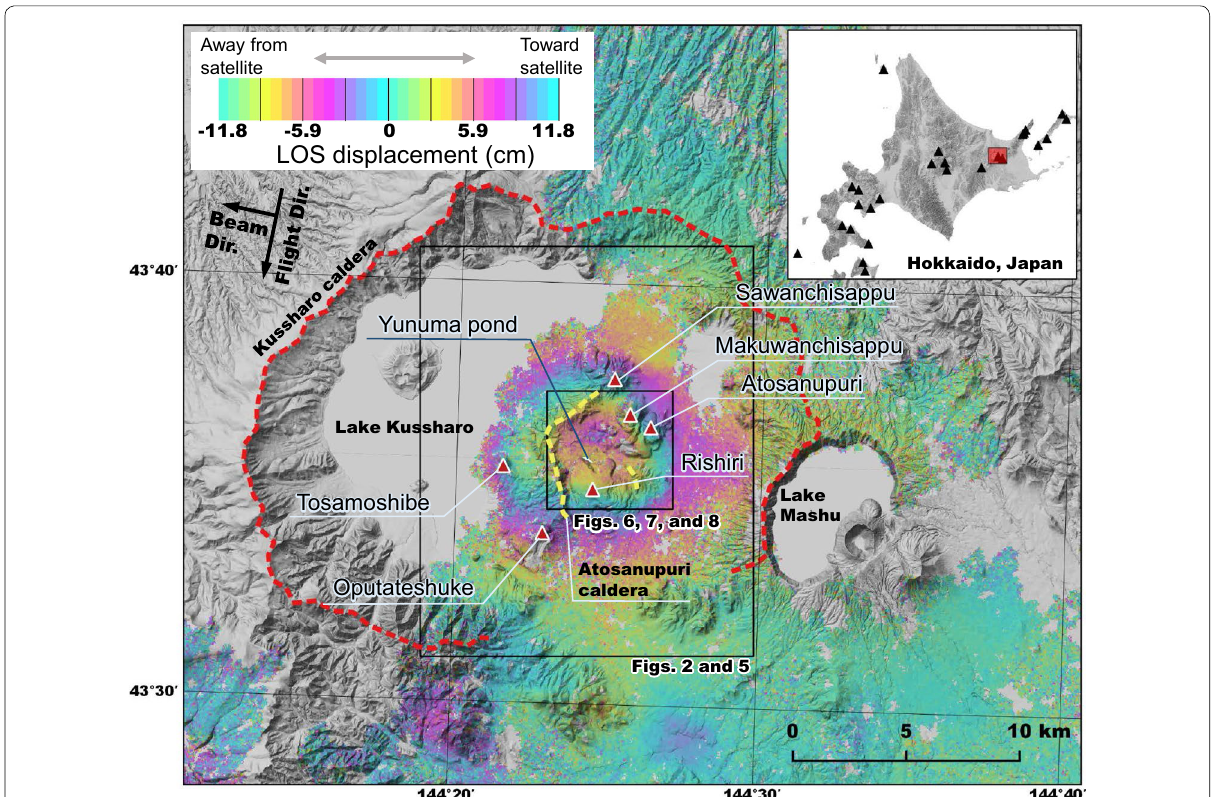
Fig. 1 A SAR interferogram showing range change between JERS-1 and the ground surface during the period from August 13, 1993 to April 21, 1995, overlaid on topographic relief of the study target area. Area of the color change at the center is the signature of the deformation detected by JERS-1 InSAR. Color scale indicates radar range change (positive values show upward and/or east-southeastward displacement). Red dashed line shows the approximate boundary of the Kussharo caldera, and the yellow dashed line shows the Atosanupuri caldera (Katsui 1962). Red triangles indicate major lava domes belonging to the Atosanupuri volcanic complex. Rectangles with figure numbers show the area of each figure. Location of this figure is shown in the inset . Black triangles in the inset indicate active